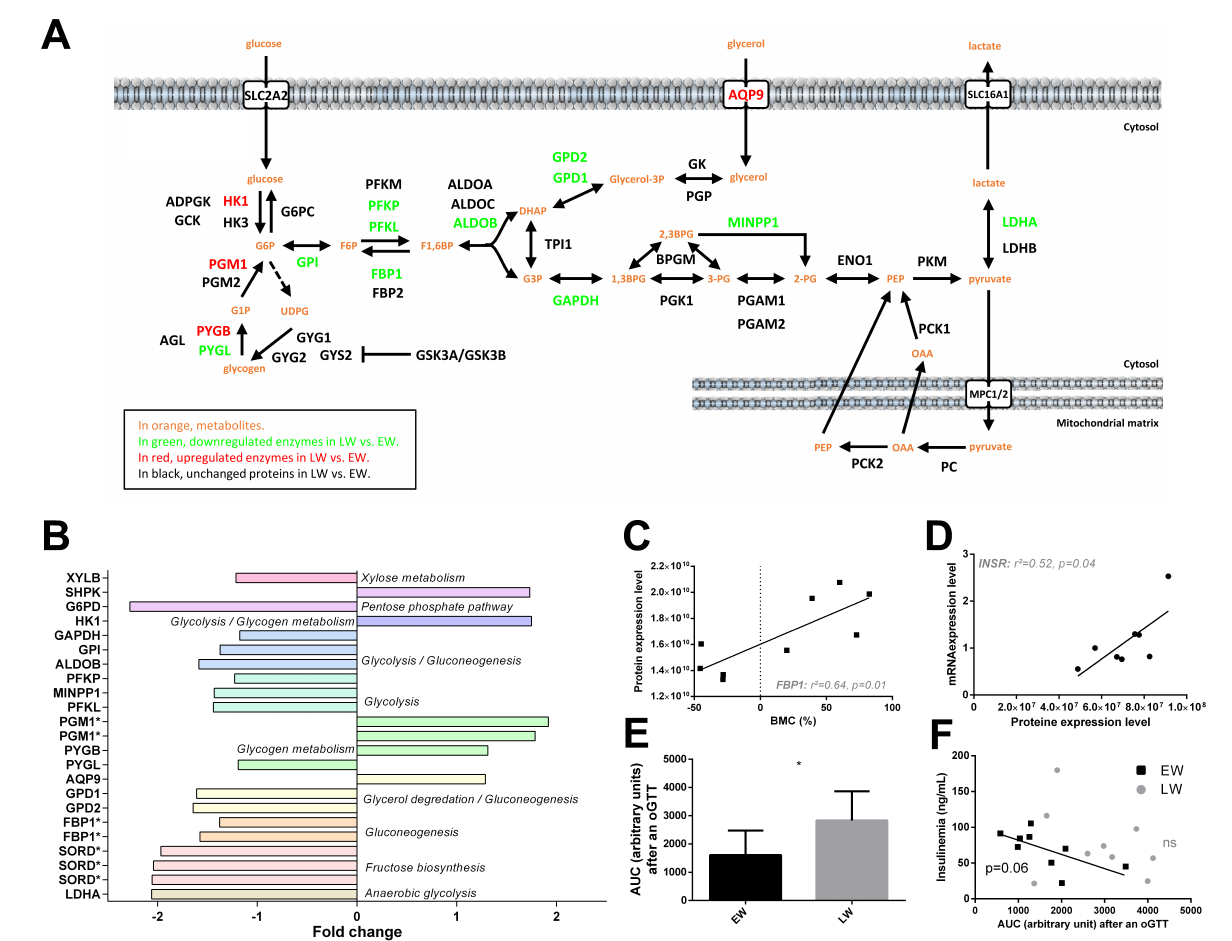
Figure 3. Regulation of liver carbohydrate metabolism and insulin signaling in grey mouse lemurs during winter. The relative abundance of liver proteins involved in carbohydrate metabolism measured in mouse lemurs (N = 5/group) in early (EW) vs late (LW) winter is shown using a color code in the corresponding pathways (panel A ), and mean fold changes in LW vs. EW can be visualized (panel B ) (presence of several isoforms of the same protein are indicated with asterisks (*)). Significant and positive correlations were found between protein expression level of fructose-1,6-bisphosphatase 1 (FBP1) and body mass changes (BMC, panel C ) and between mRNA and protein levels of the insulin receptor (INSR, panel D ). Retrieving data from a previous study showing the most extreme phenotypes (EW vs. LW) revealed a greater intolerance to glucose in LW than in EW during oral glucose tolerance tests (oGTT, panel E ; results are presented as the means ± SEM) and a negative correlation between insulinemia and glucose intolerance (AUC, area under the curve) for EW lemurs, albeit not a significant one (panel F ). * indicates significance at p < 0.05 between EW and